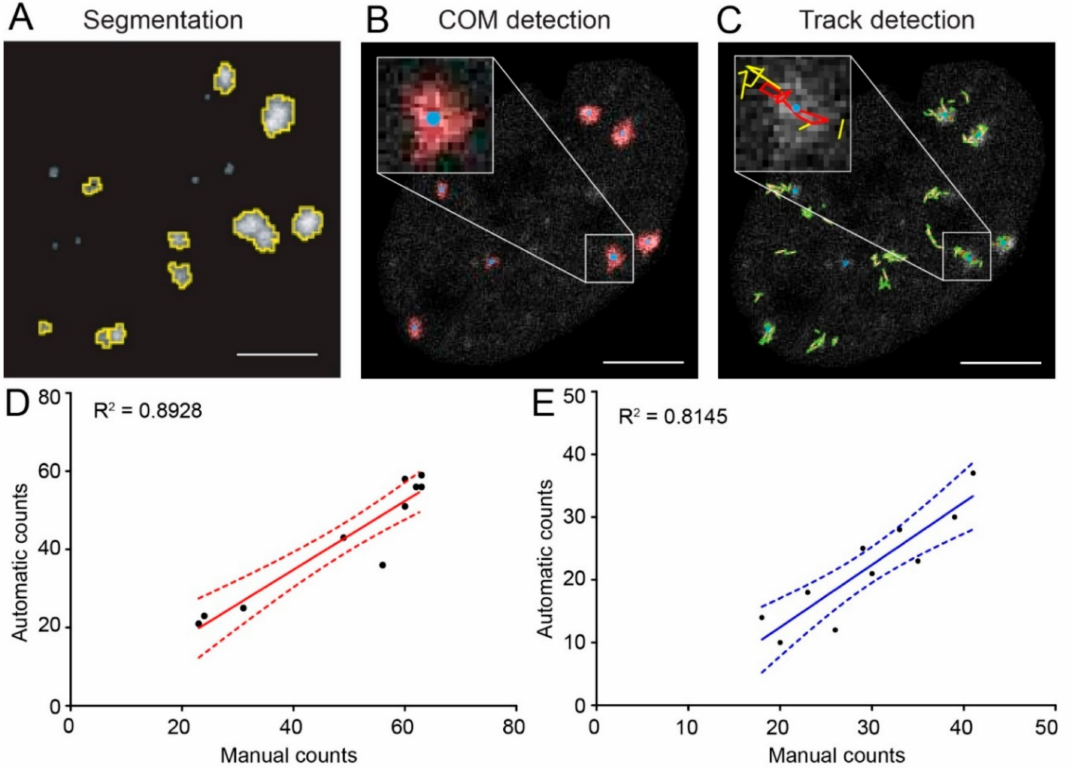
Figure 1. Overview of focus segmentation and focus track analysis. U2OS cells stably expressing p53-binding protein 1 (53BP1)-GFP were irradiated with 2 Gy of α -particle or X-ray irradiation. ( A ) ImageJ scripts were using for focus segmentation. ( B ) Center of mass (COM) per focus was calculated. ( C ) Center of mass was linked to consecutive frames (if COM was ≤ 0.7 µ m). Tracks are indicated in red (active track at this time-point) or yellow (past track not active at this time-point). Scale bar indicates 5 µ m. Segmentation of foci was correlated to manual counts of foci for both α -particle irradiation ( D ) and X-ray irradiation ( E ). For both treatments, three nonconsecutive frames were counted in 10 random nuclei. The averages of these counts are